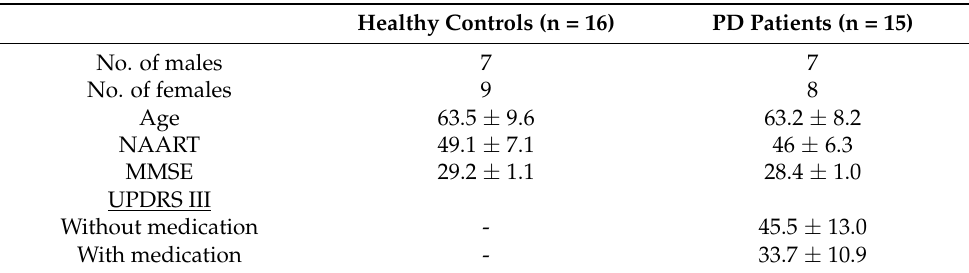
Table 2. Summary of subjects’ clinical characteristics in the PD dataset used in this study. Values are represented as mean (standard deviation).